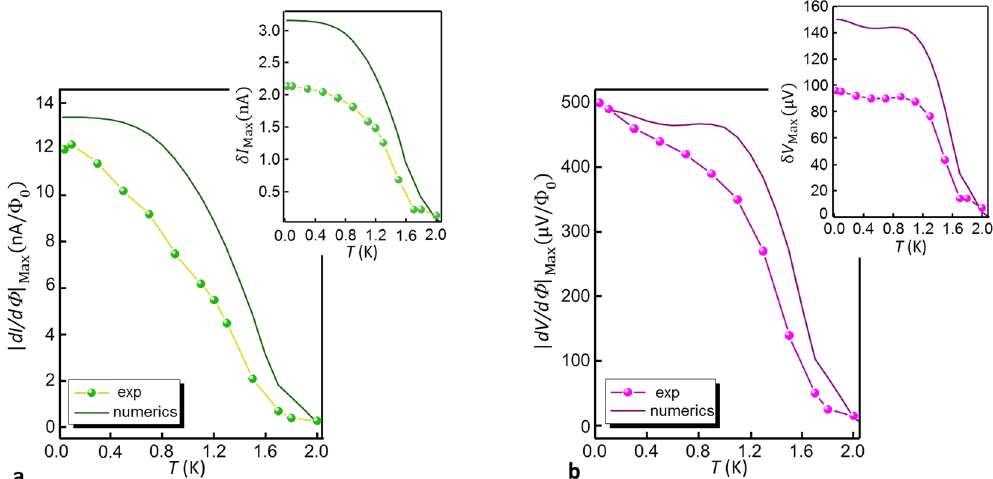
Figure 5. Temperature evolution of the magnetometer performance. ( a ) and ( b ) Temperature dependence of the maximum absolute value of the flux-to-current (| dI / d Φ | Max ) and flux-to-voltage (| dV / d Φ | Max ) transfer function, respectively. The insets show the maximum peak-to-peak current amplitude ( δ I Max ) and the maximum peak-to-peak voltage amplitude ( δ V Max ), respectively. The lines connecting experimental data are guides to the eye. The theoretical predictions based on the simplified model are also plotted (solid